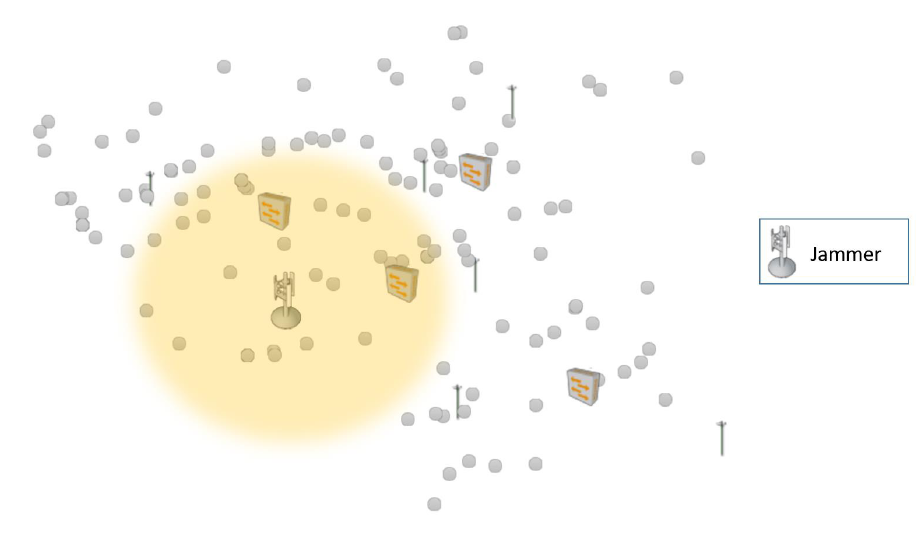
Figure 6. Location of jammer in the modeled communication